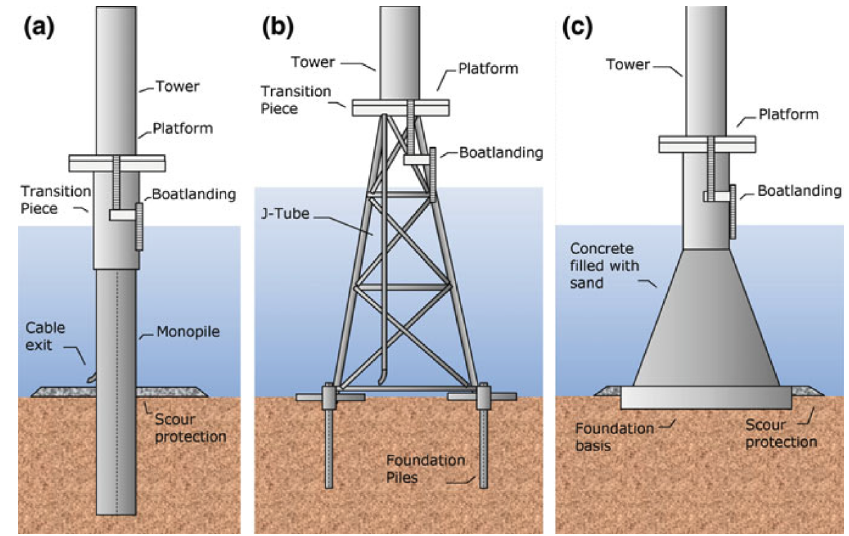
Figure 1. Fixed type WT foundations [1]. Monopile ( a ), jacket ( b ), and gravity-based ( c